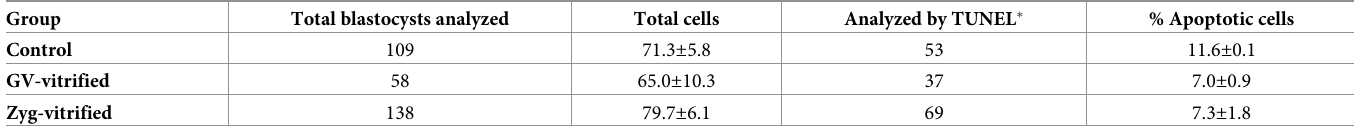
Table 4. Total cell numbers and apoptosis in Day 7 blastocyst obtained from oocytes vitrified either at the GV stage (GV-vitrified) or at the zygote stage (Zyg- vitrified). Group Total blastocysts analyzed Control GV-vitrified Zyg-vitrified 138 Eight replications were performed.